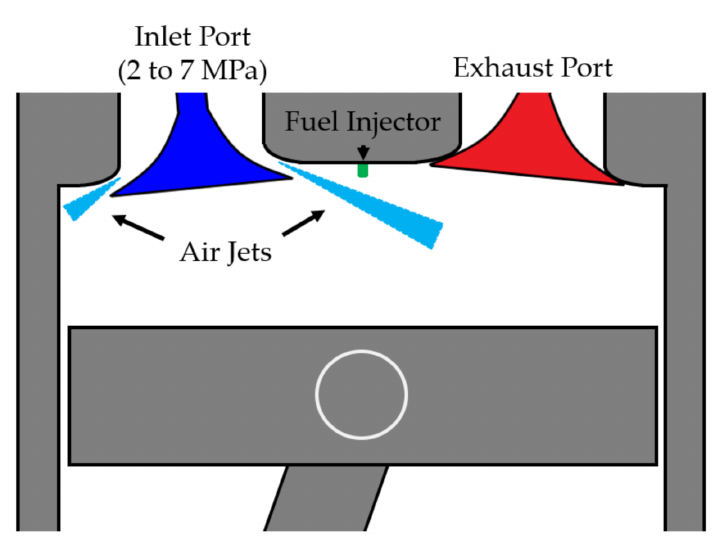
Figure 4. Simple 2D diagram of combustion chamber with inlet air jets in